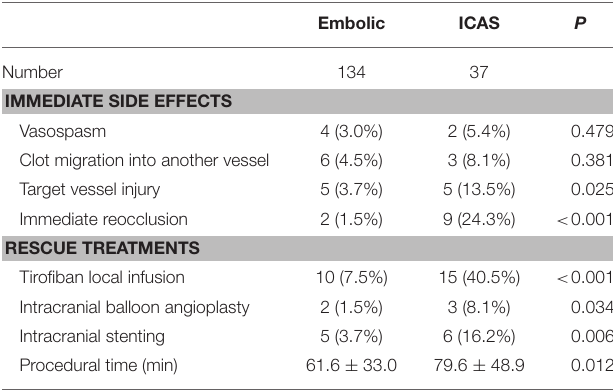
TABLE 3 | Procedural outcomes on the primary use of Solitaire thrombectomy (not